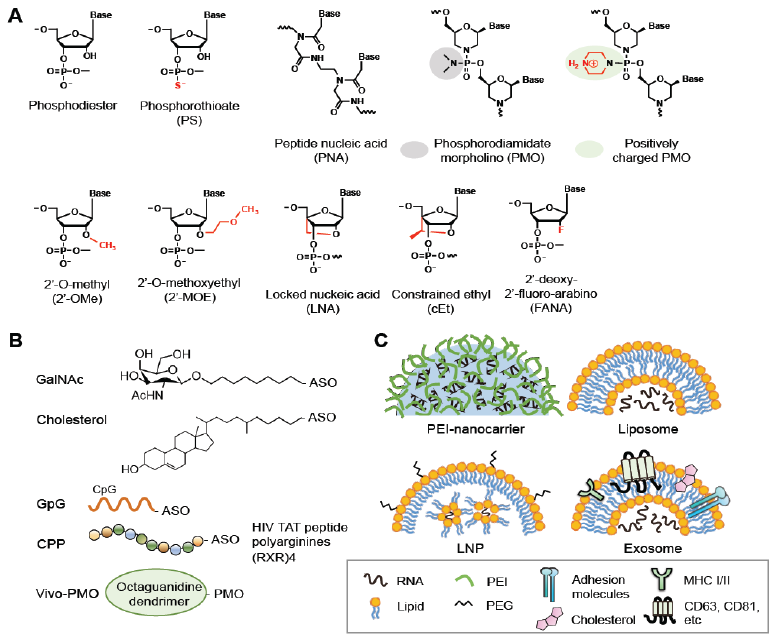
Figure 2. Modifications, bioconjugations and delivery vehicles of ASOs. ( A ) Structures of backbone or sugar-modified ASOs as well as PNA and PMO oligomers. ( B ) Bioconjugates of ASOs include GalNac, Cholesterol, CpG DNA and CPP (R, arginine; X, 6-aminohexanoic acid). Vivo-PMO is an PMO covalently linked to an octa-guanidine dendrimer. ( C ) Representative delivery vehicles of ASOs include EPI-nanocarrier, liposome, LNP, and exosome. Adapted from [15], Spring Nature Limited, 2020; [20], MDPI, 2021.